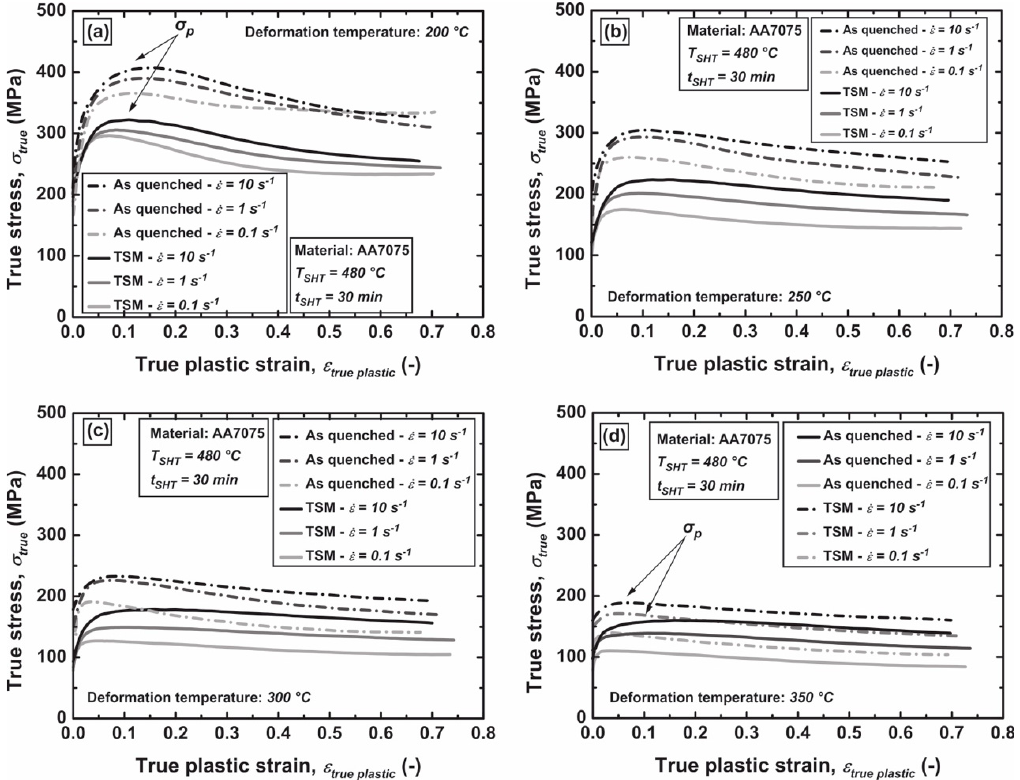
Figure 1. Hot deformation behavior of the precipitation-hardenable aluminum alloy AA7075 at different deformation temperatures of ( a ) T DT = 200 ◦ C, ( b ) T DT = 250 ◦ C, ( c ) T DT = 300 ◦ C and ( d ) T DT = 350 ◦ C and strain rates ranging from true stress–plastic strain curves of TSM condition and the dashed lines the hot deformation curves of the as-quenched condition.